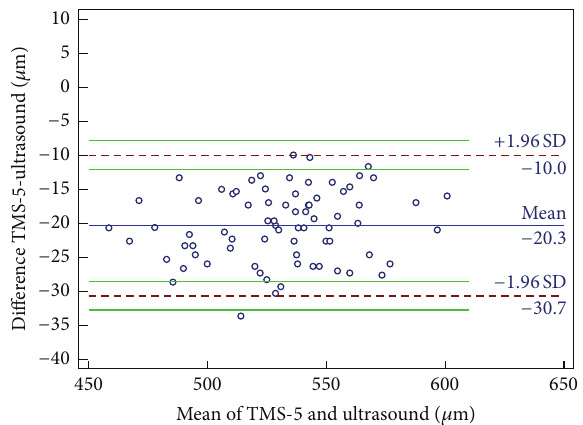
Figure 2: Bland-Altman plots of agreement in the thinnest corneal thickness measurement between the Scheimpflug-Placido topo- graphic modeling system (TMS-5) and ultrasound pachymetry. The blue solid line indicates the mean difference (bias). The dashed lines represent the 95% limits of agreement. The upper and lower green solid lines represent the 95% limits of